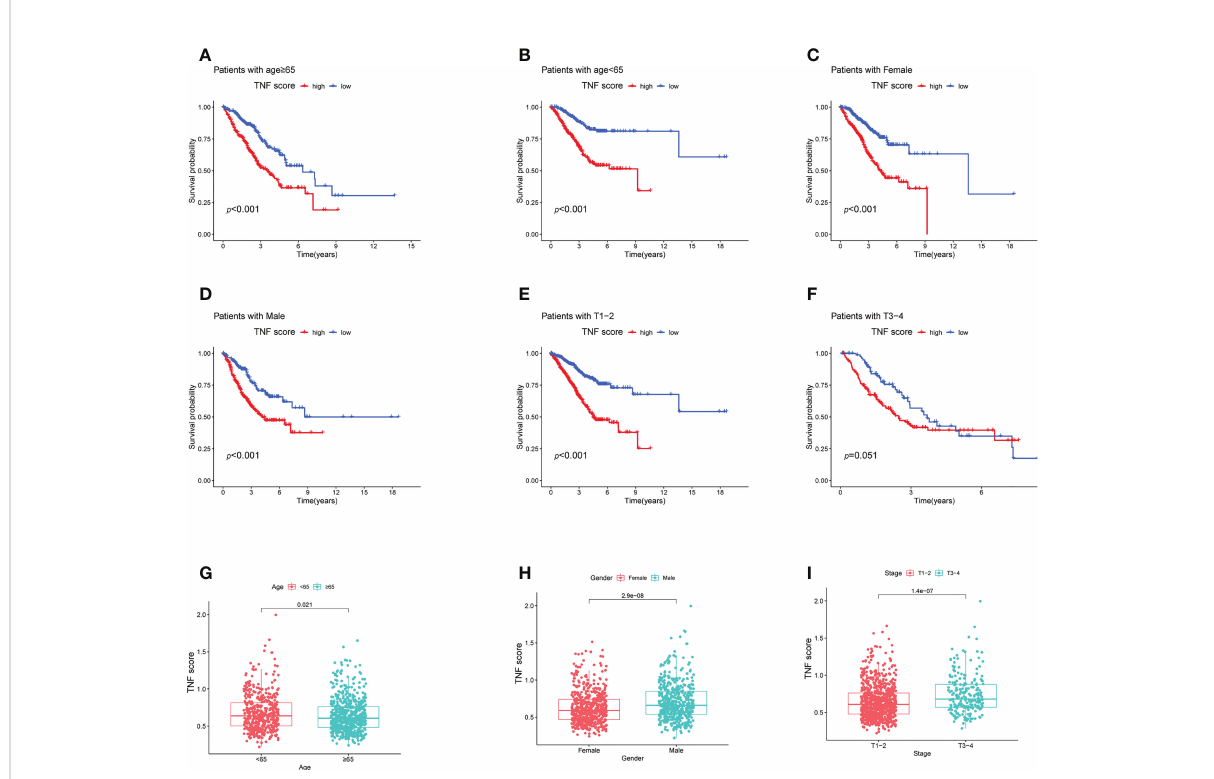
FIGURE 5 Survival analysis of the clinical strati fi cation of OS in the LUAD cohorts. (A – F) Kaplan – Meier survival analysis of the high and low TNF score groups for different clinicopathological characteristics. (A, B) Age ≥ 65 or < 65 years old; (C, D) female or male; (E, F) T1 – 2 or T3 – 4. (G – I) Boxplot of the high and low TNF score groups for different clinicopathological characteristics. (G) Age <65 or ≥ 65 years old; (H) female or male; (I) T1 – 2 or T3 –